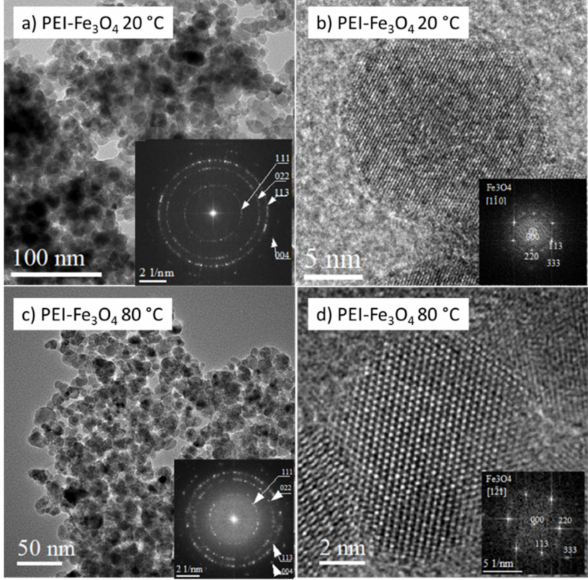
Figure 3. Microstructure of PEI-coated Fe 3 O 4 NPs prepared at 20 ◦ C ( a , b ) and 80 ◦ C ( c , d ), respectively. Low-magnification TEM images of NPs with relevant FFT patterns in insets ( a , c ). HRTEM/ARTEM images of individual NPs with relevant FFT patterns in insets ( b , d